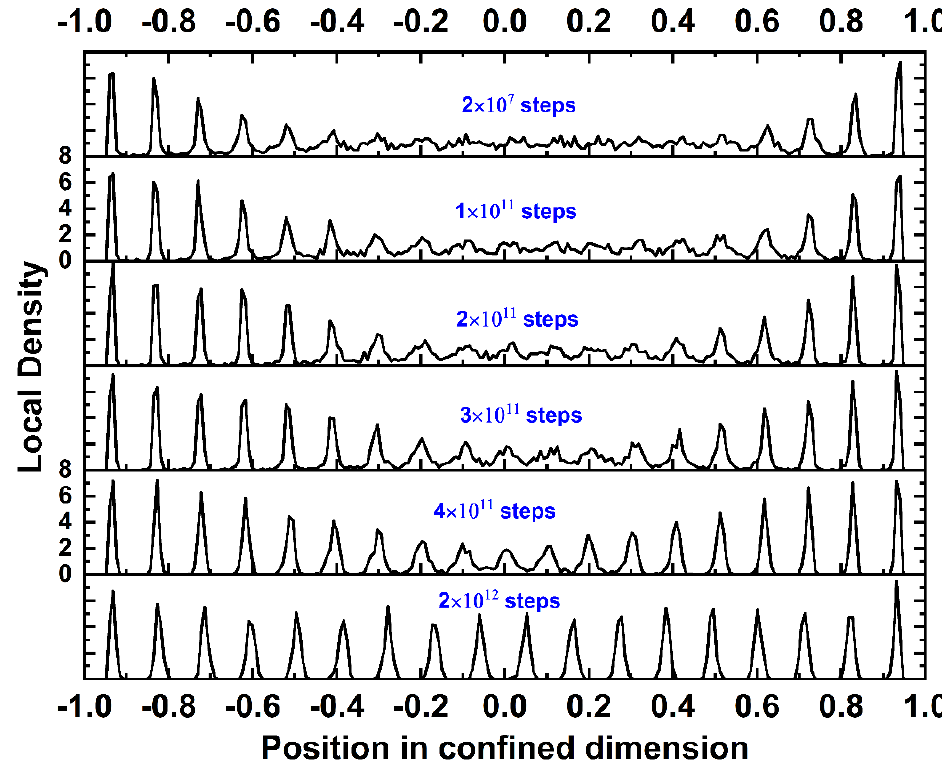
Figure 7. Stacked plots of the local density profile as a function of the position in the confined dimension for the N = 100 and ϕ = 0.60 system. Different plots correspond to different steps (frames) along the MC trajectory.